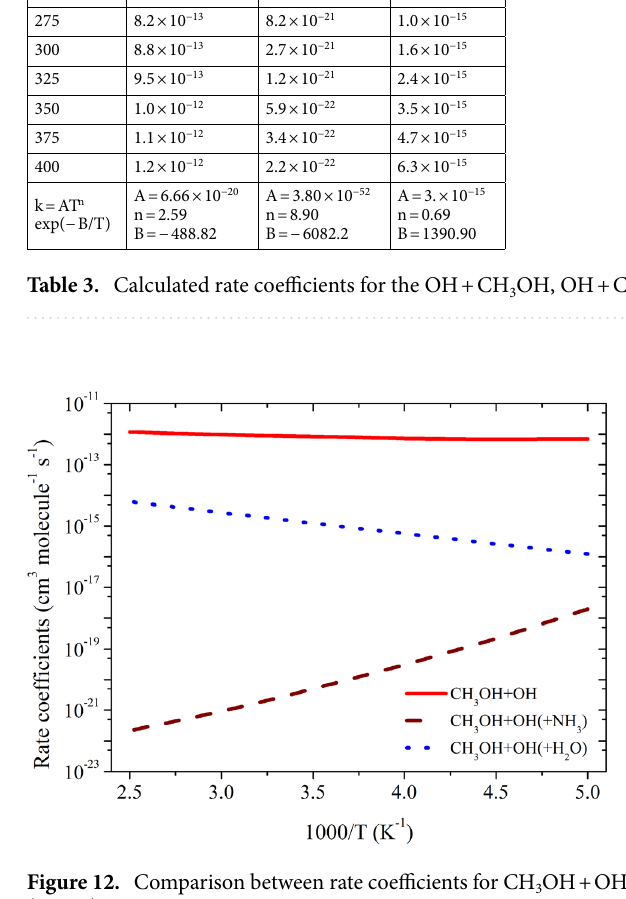
Figure 12. Comparison between rate coefficients for CH 3 OH + OH, CH 3 OH + OH (+ NH 3 ) and CH 3 OH + OH (+ H 2